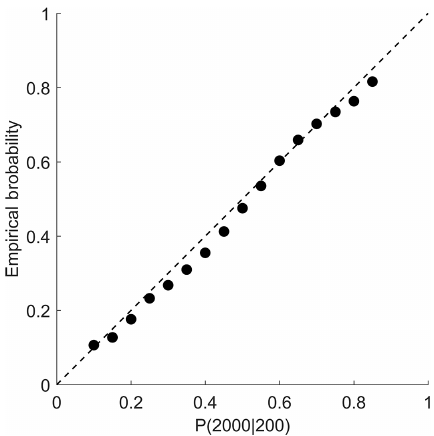
Figure 12. Empirical values of probability computed from observa- tions of fire events as a function of P( 2000 | 200 ) derived from the daily model during the calibration period (2004–2016).